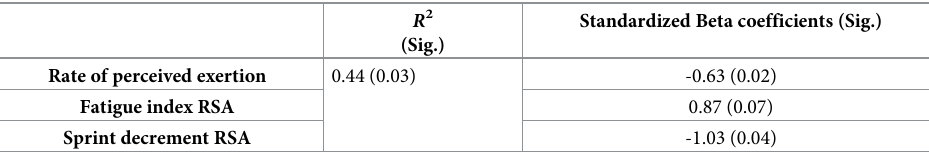
Table 5. Fatigue predictors for kicking accuracy. Linear